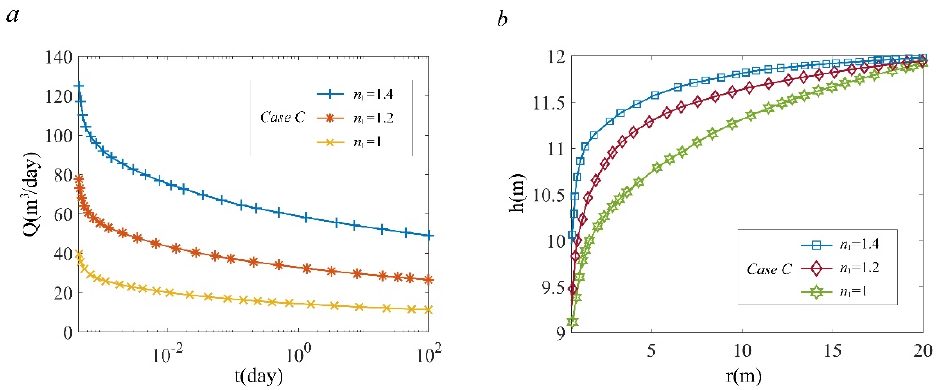
Figure 6. Dynamic development of ( a ) 𝑄 – 𝑡 curves in a constant radial distance and ( b ) ℎ – 𝑟 curves at a fixed time moment with different non-Darcian coefficients.